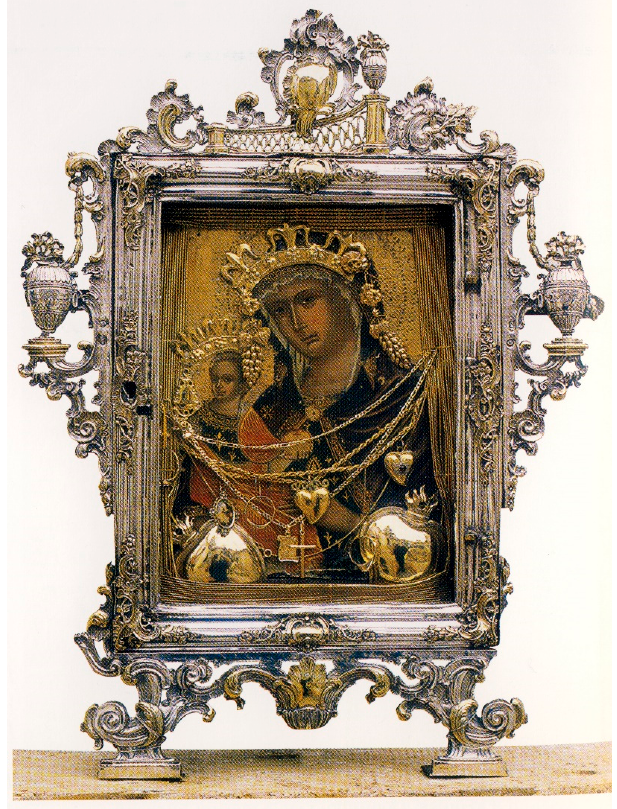
Figure 17. “Our Lady of the Miracle” (Gospa od Č uda), Rab, Benedictine Convent of Saint Andrew (Samostan Benediktinki Svetog Andrije) (taken from Domijan 2007, p. 126).